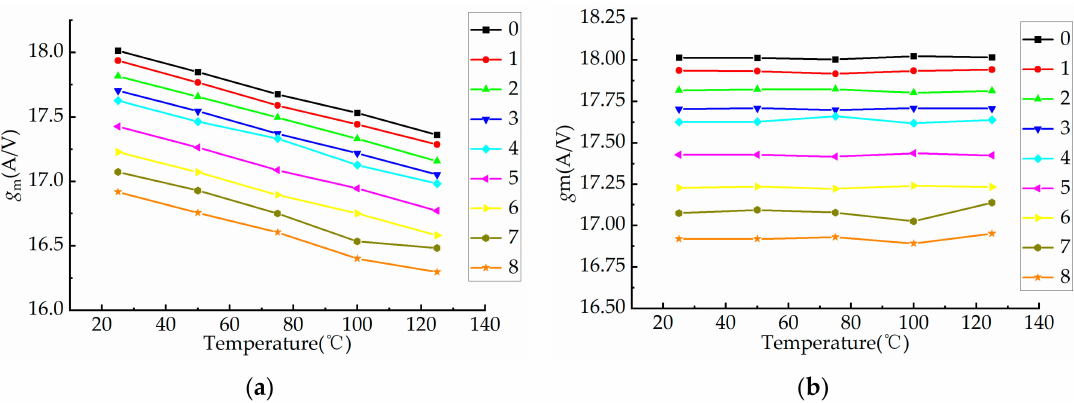
Figure 12. Module transconductance of Chip 2 with bond wire failure: ( a ) before temperature calibration and ( b ) after temperature calibration.